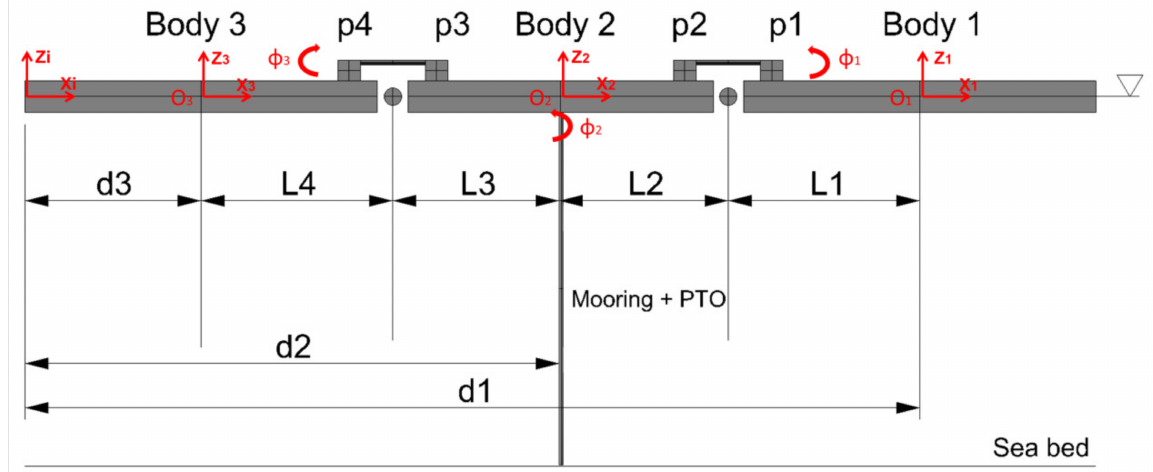
Figure 3. Schematic of the triple modular assembly corresponding to one of the device’s three main